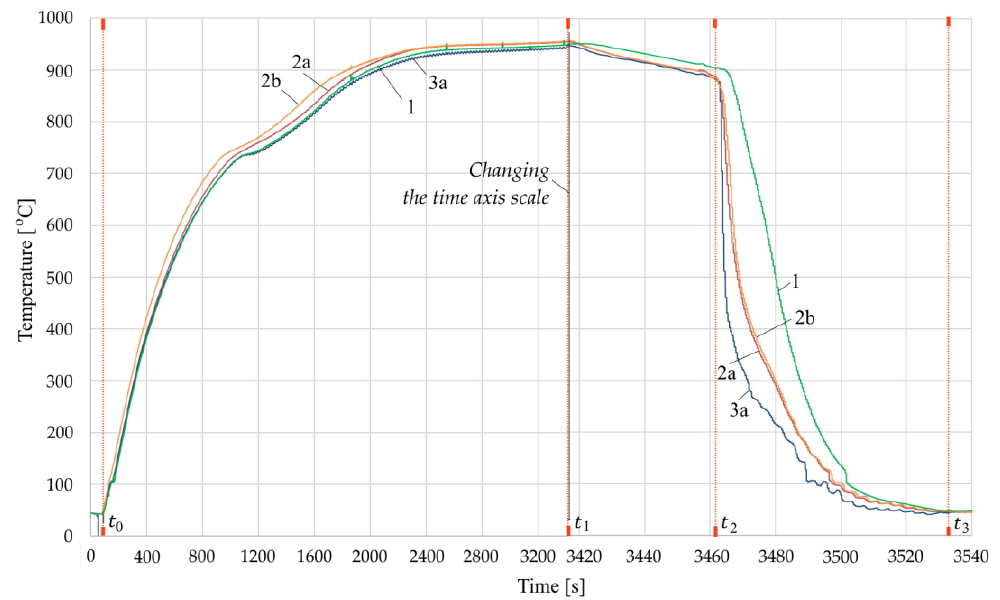
Figure 13. Plots of temperature changes, measured using thermocouples in test No. 2 during heating and cooling. Designations of the curves: 1 — at the center of the thickness in the middle of the plate width; 2a — at the top in the middle of the width; 2b — at the top at the edge; and 3a — at the bottom in the middle of the width. Designations of the key moments of time: t 0 — entry into the furnace; t 1 — exit from the furnace; t 2 — entry into the first zone of RQM; t 3 — exit from RQM.